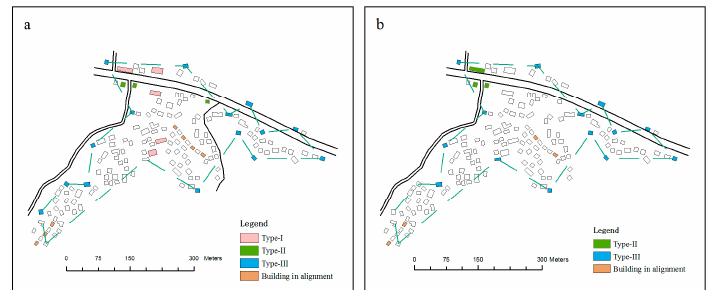
Figure 22. Must-be-selected buildings in selection unit A when the target scale is: ( a ) 1:25,000, and ( b ) 1:50,000. The green dashed line is the simplified boundary line.